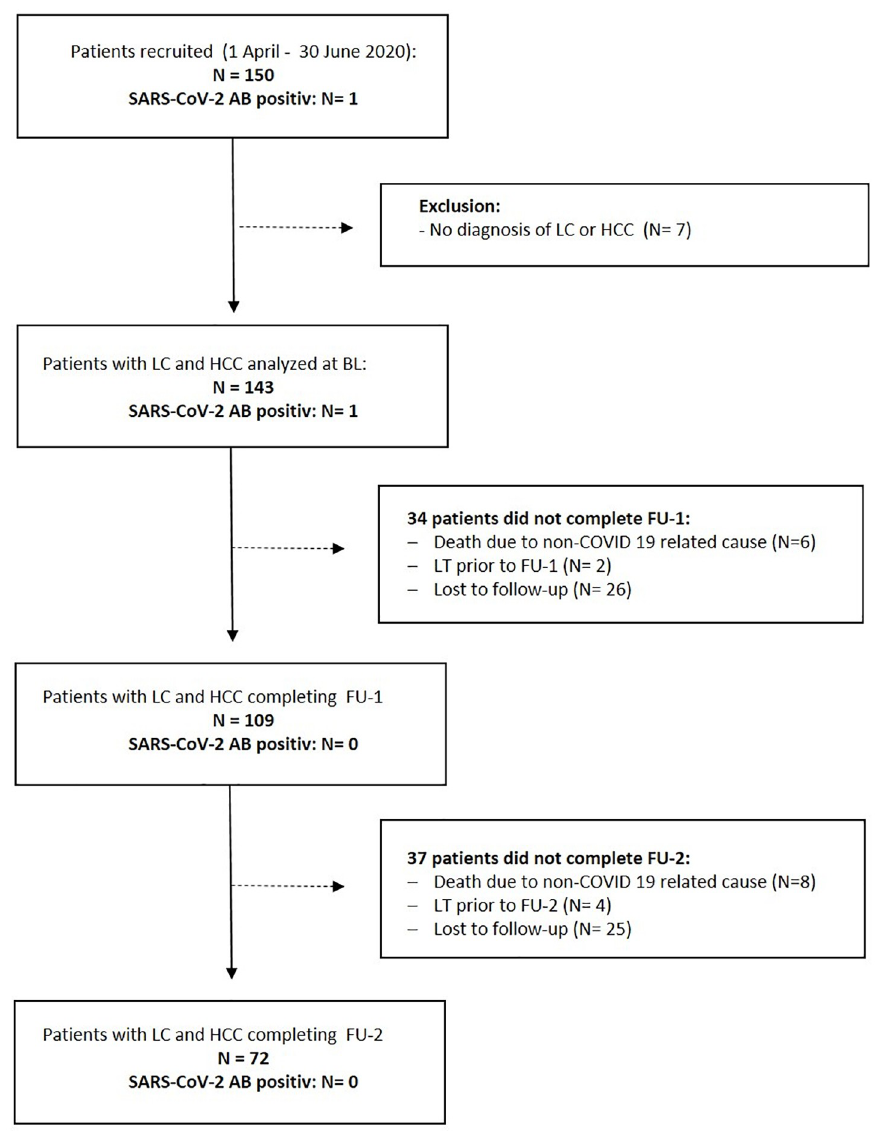
Fig 1. Flow chart of the study. FU-visits were conducted six to eight weeks (FU-1) and six months (FU-2) after enrolment. Since patients were only tested in the context of routine presentations in the outpatient department, a total of 51 patients did not complete FU-1 or FU-2, no routine presentation was indicated. Legend: HCC: hepatocellular carcinoma; LC: liver cirrhosis; LT: liver transplantation.